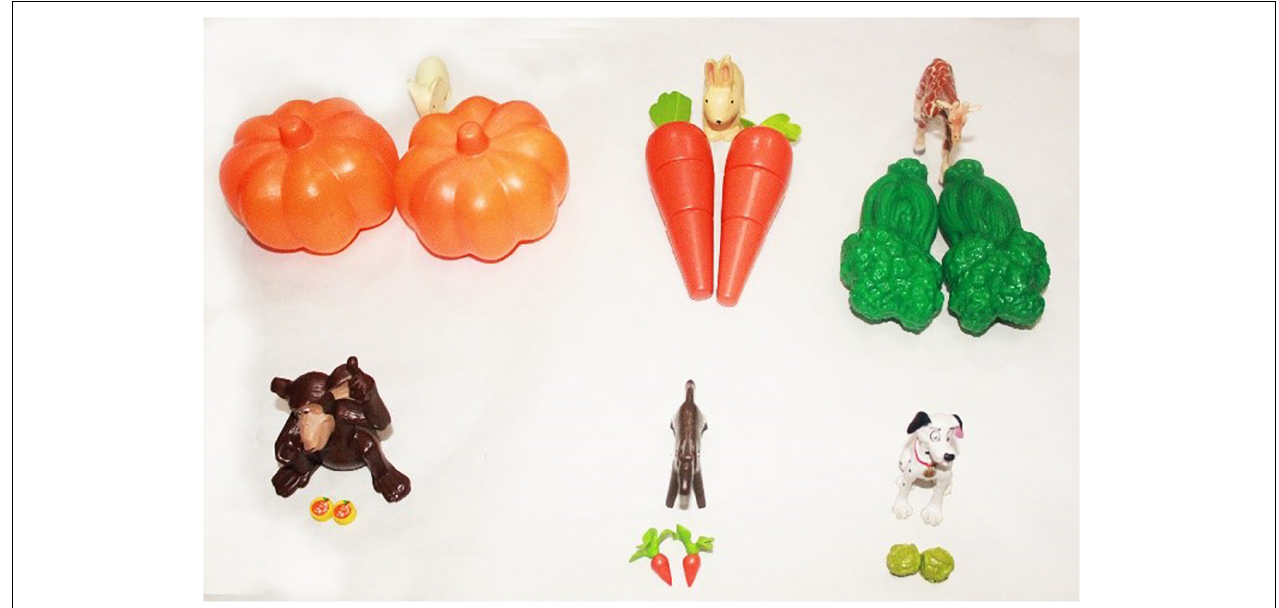
FIGURE 2 | Last scene of the story (the amount-oriented context).